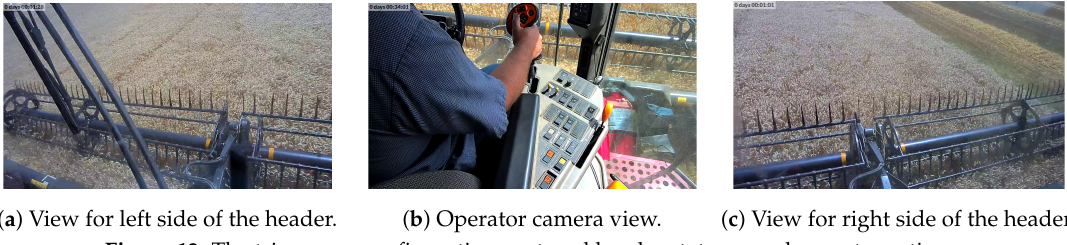
Figure 13. The tri-camera configuration captured header statuses and operator